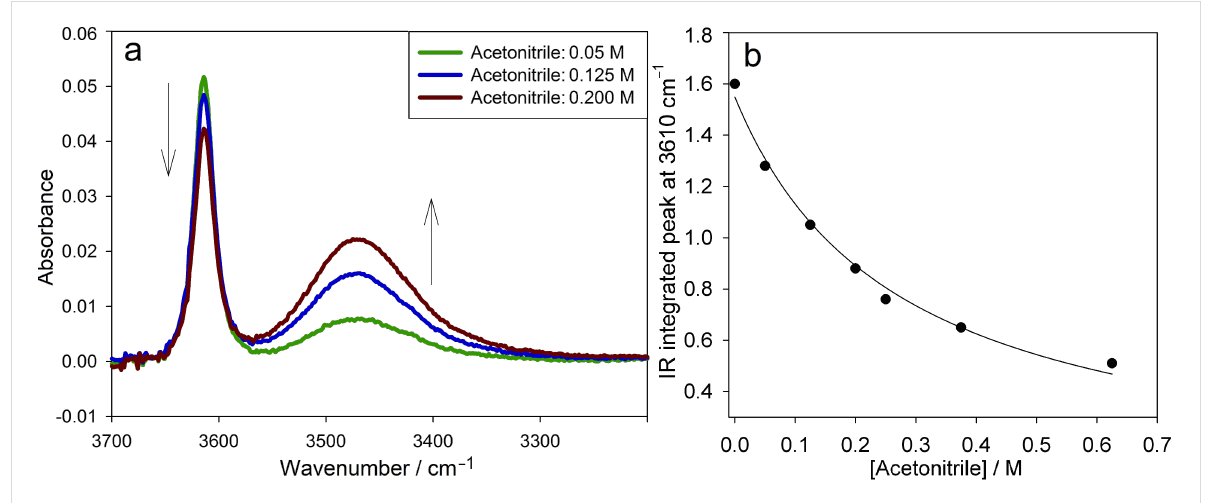
Figure 2: The O–H stretching region of representative FTIR spectra of compound 6b (10 mM) in CCl 4 containing increasing amounts of acetonitrile as co-solvent (a) and corresponding plot of the integrated signal at 3610 cm − 1 versus the concentration of acetonitrile, fit to Equation 2